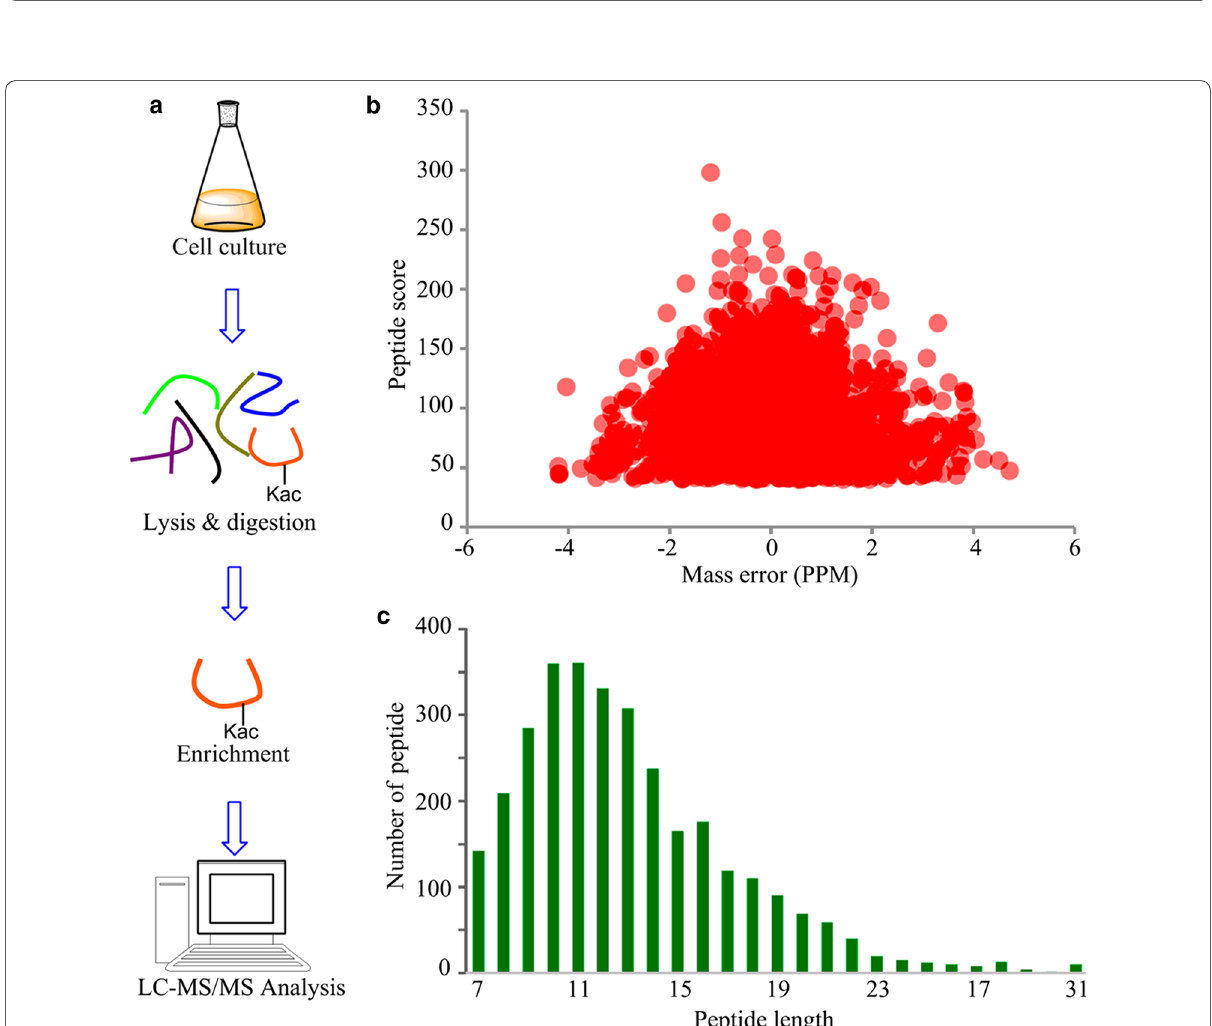
Fig. 2 Proteome-wide identification of lysine acetylation sites in Y. lipopytica . a Overview of experimental procedures used in this study. b Mass error distribution of all identified peptides. c Peptide length